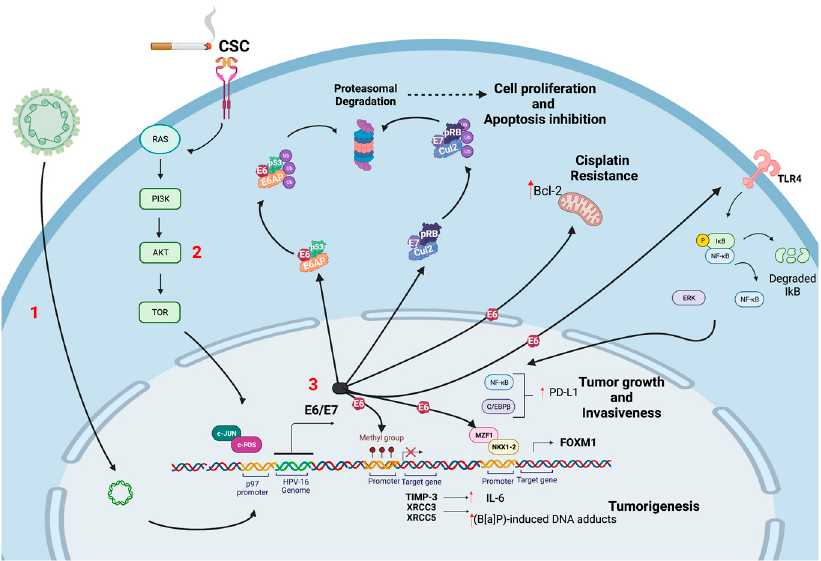
Figure 2. Molecular alterations in HPV-associated lung cancer. ( 1 ) HR-HPV infection and viral genome integration leads to E2 ORF disruption, resulting in early promoter (p97 in HPV16) activation ( 2 ) CSC can activate PI3K/Akt/mTOR signaling pathway, thus cooperating for increased HPV early promoter activation and E6/E7 overexpression; ( 3 ) HR-HPV E6/E7 oncoproteins induce p53 and pRB ubiquitination and degradation, in turn, promoting apoptosis inhibition and cell proliferation. In addition, HR-HPV E6 promote increased Bcl-2 levels and cisplatin resistance, the expression of PD-L1 through the ERK-C/EBP β -TLR4-NF- κ B signaling pathway, thus increasing tumor growth and invasiveness; induction of FOXM1 by E6 oncoprotein through the MZF1/NKX2-1 axis and the E6-induced promoter hypermethylation of the XRCC3 and XRCC5 DNA repair genes that increase tumorigenesis. Created using BioRender.